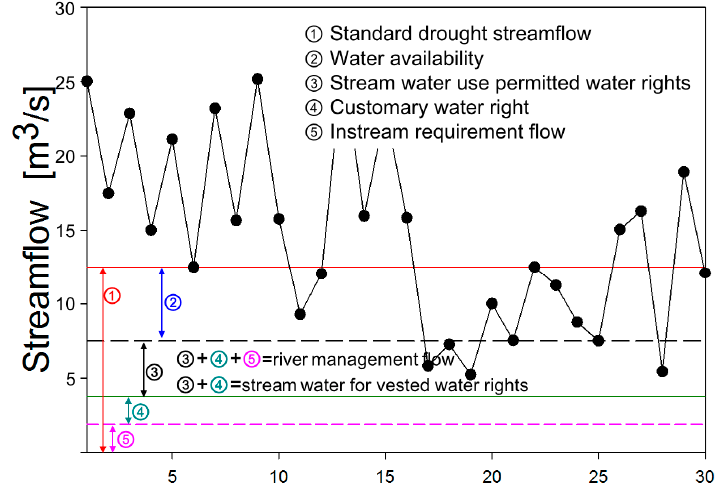
Figure 6. Concept of water rights in South Korea.